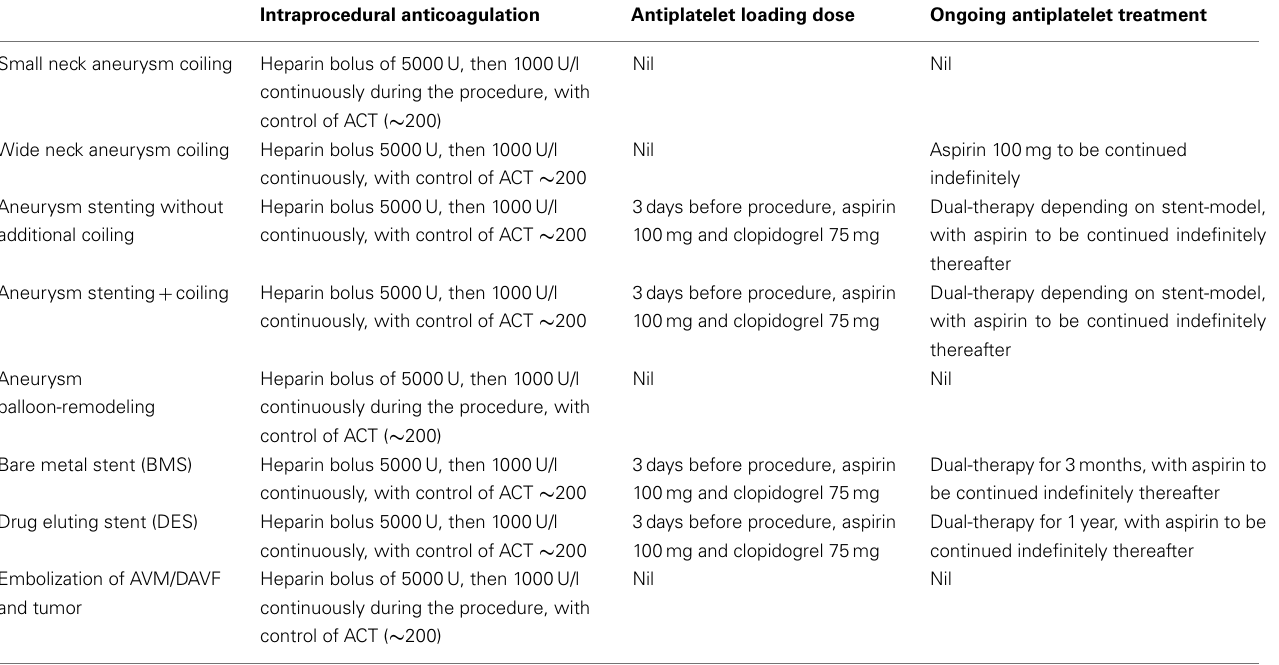
Table 1 |Anticoagulation recommendations for neurointerventional